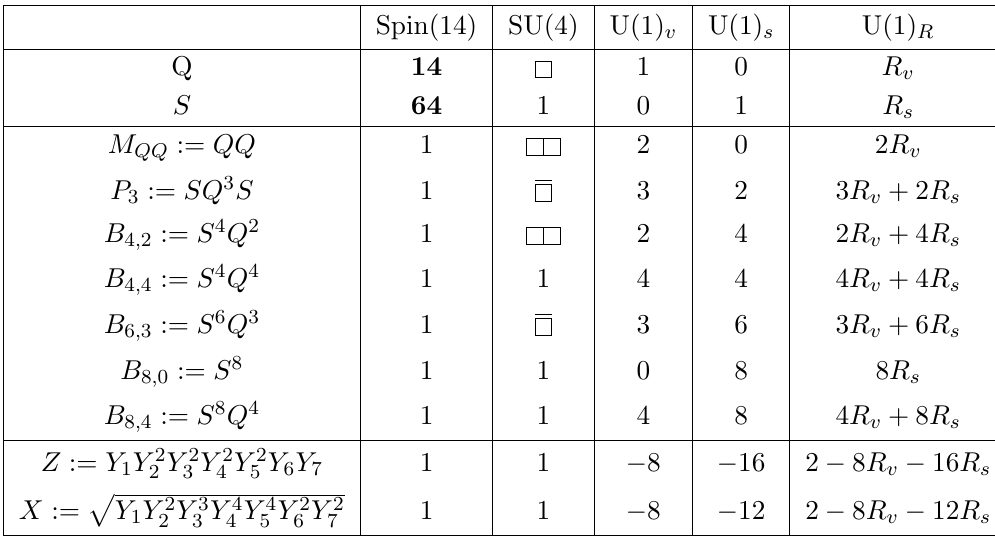
Table 24 . 3d N = 2 Spin(14) theory with ( N v ; N s ; N s 0 ) = (4 ; 1 ;